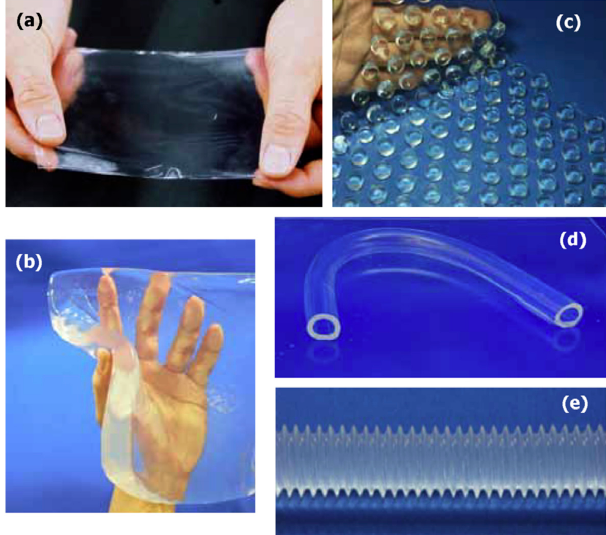
Figure 1. Nanocomposite hydrogels gels with various shapes: ( a ) thin film, ( b ) sheet, ( c ) uneven sheet, ( d ) hollow tube, and ( e ) bellows. Reprinted with permission from Reference [8]. Copyright 2007 Elsevier.